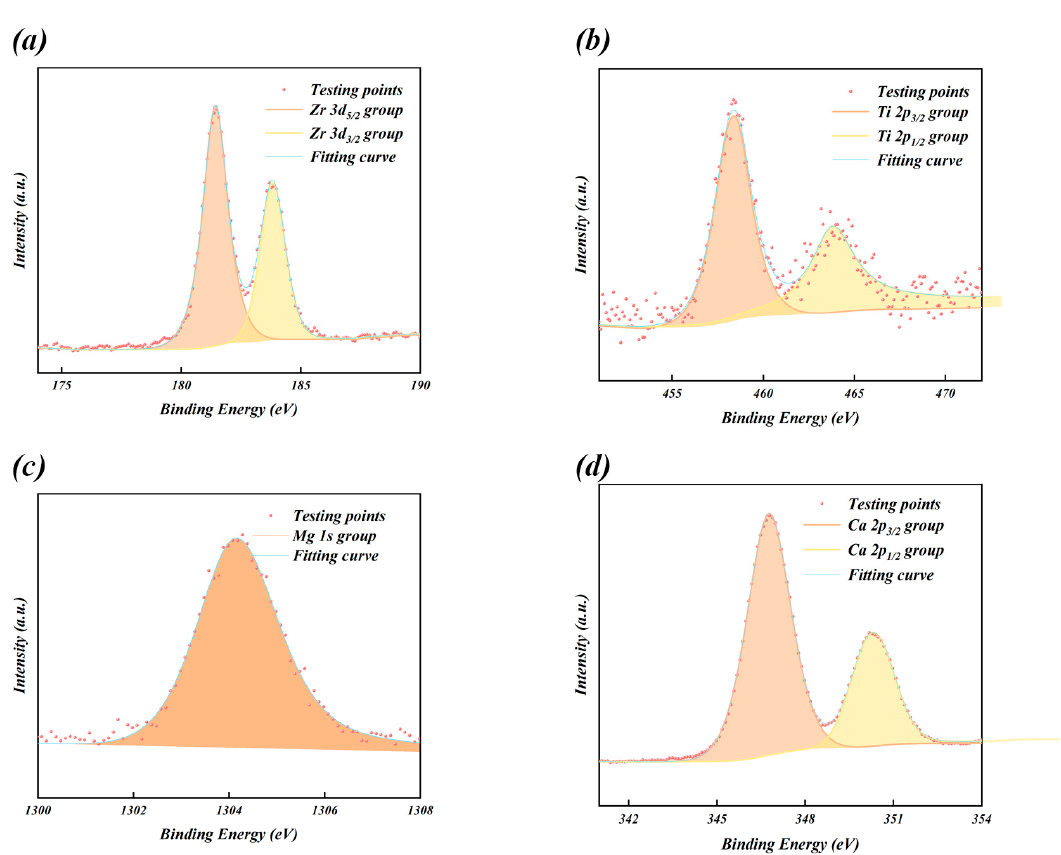
Figure 4. XPS pro fi les of oxide metal elements in Fe-Si-Cr/AO x soft magnetic cores: ( a ) Zr, ( b ) Ti, ( c ) Mg, and ( d ) Ca. ( c ) Mg, and ( d )